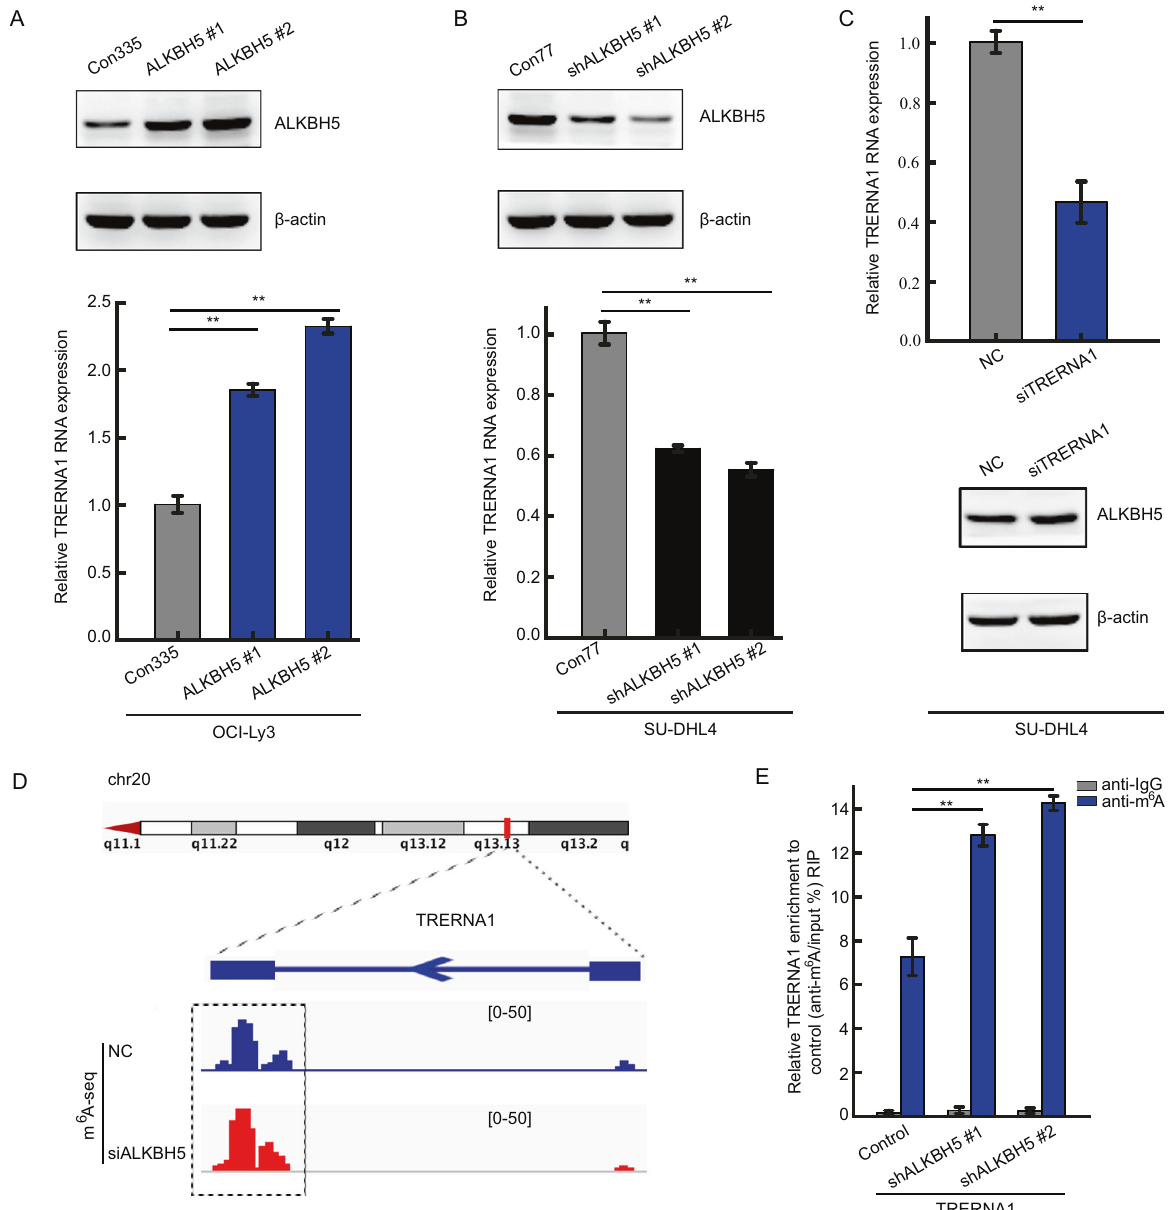
Fig. 3 ALKBH5 upregulates TRERNA1 expression via m 6 A modi fi cation. A TRERNA1 levels in OCI-Ly3 stable ALKBH5 overexpression and control cells were veri fi ed. B TRERNA1 levels in SU-DHL4 stable ALKBH5 knockdown and control cells were veri fi ed. C ALKBH5 levels were veri fi ed by western blot analysis after transfecting cells with NC or siTRERNA1 for 48 h. D m 6 A levels of TRERNA1 were measured in ALKBH5- silenced cells by MeRIP-seq. E MeRIP-qPCR results veri fi ed the TRERNA1 m 6 A modi fi cation upon ALKBH5 silencing. The data are presented as the mean ± SD. ** P < Fig. 6E, the volumes of xenograft tumors in the shTRERNA1 group were much lower than those of the control vector group. Western blot results con fi rmed that TRERNA1 knockdown upregulated p21 expression in the xenograft models (Fig. 6F). Moreover, we detected that the enrichment of EZH2 at the p21 promoter was decreased in the xenograft when TRERNA1 was downregulated, which con fi rmed the TRERNA1-mediated p21 inhibition (Fig. 6G). As shown in Fig. 6H, I, the tumor growth models showed that ALKBH5 knockdown signi fi cantly inhibited tumor growth. TRERNA1 expression was decreased in the shALKBH5 group derived in vivo (Fig. 6J). On the contrary, p21 expression was upregulated in the shALKBH5 group (Fig. 6K). These data indicated